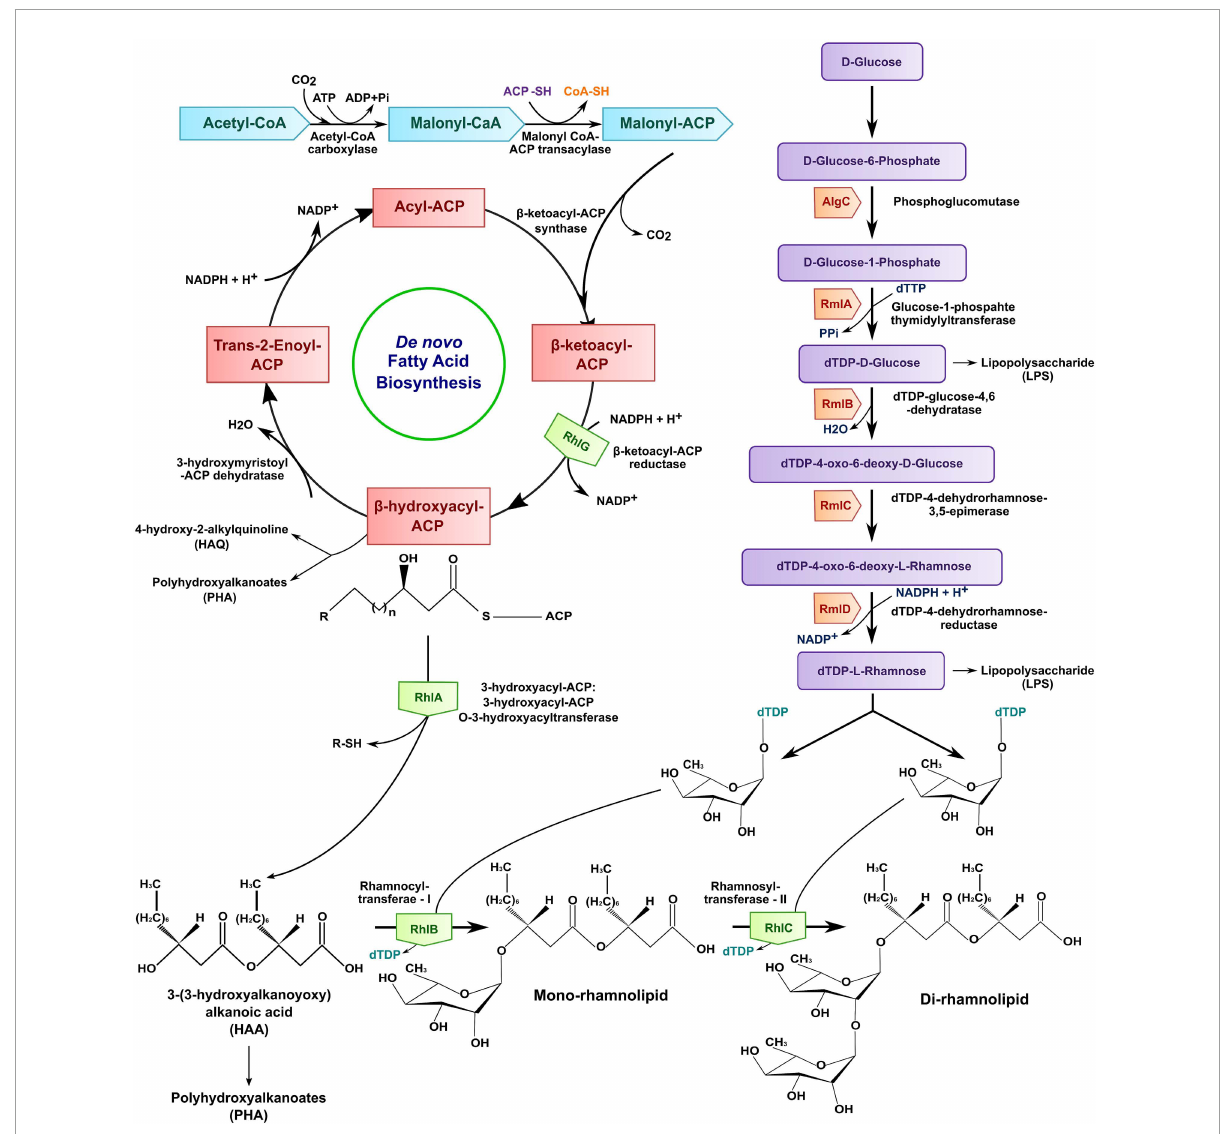
FIGURE5 Biosynthesis of rhamnolipid by Pseudomonas